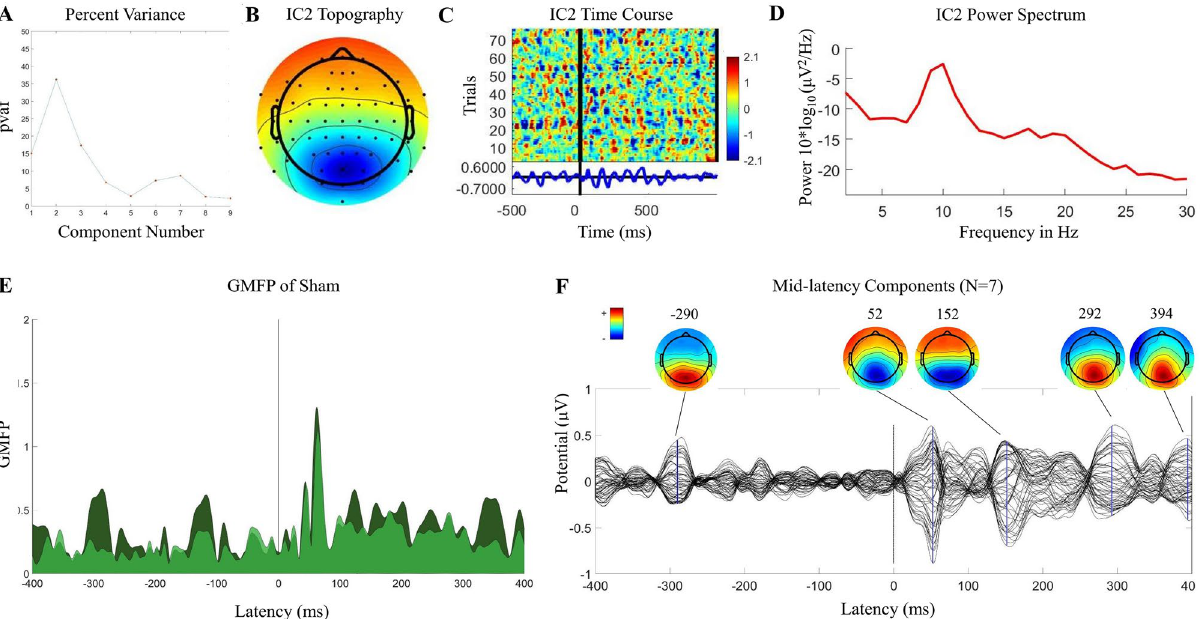
Figure 5. Mid-latency components. Properties of mid latency component in a one representative participant in sham stimulation condition ( A – E ). ( A ) Percent variance contributing to mid latency window in sham stimulation in all components, showing peak contribution in component 2. For all participants, a threshold PVAF of 28% was used to select largest mid-latency contributors in sham stimulation condition. ( B ) Topography of component 2, showing posterior midline projection. ( C ) ERP Image of component 2, showing time course across all trails and presence of activity in baseline period. ( D ) Spectral profile of component 2, with peak frequency in alpha band. ( E ) GMFP pre (darker) and post (lighter) removal of component 2, showing similar reduction in baseline and post-TMS windows. ( F ) TEP/topography of all mid latency components contributing more than 28% variance in mid latency window in sham stimulation condition (N = 7) from full group